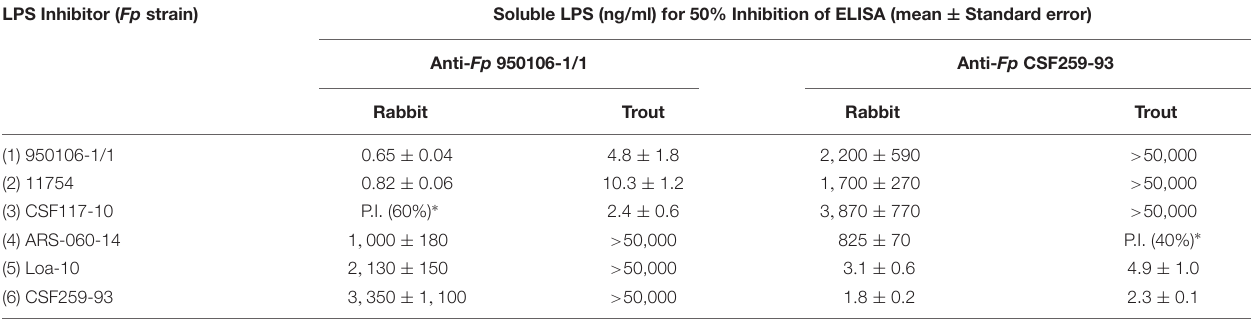
TABLE 3 | ELISA Inhibition of rabbit and rainbow trout anti- Fp antibody binding to homologous LPS by LPS of different Fp strains. LPS Inhibitor ( Fp strain) Soluble LPS (ng/ml) for 50% Inhibition of ELISA (mean ± Standard error)